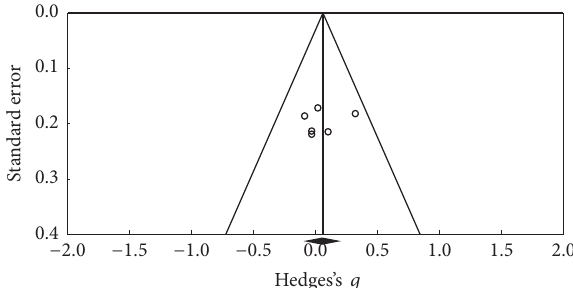
Figure 12: Funnel plot for standard error in publications of Raven Matrix.